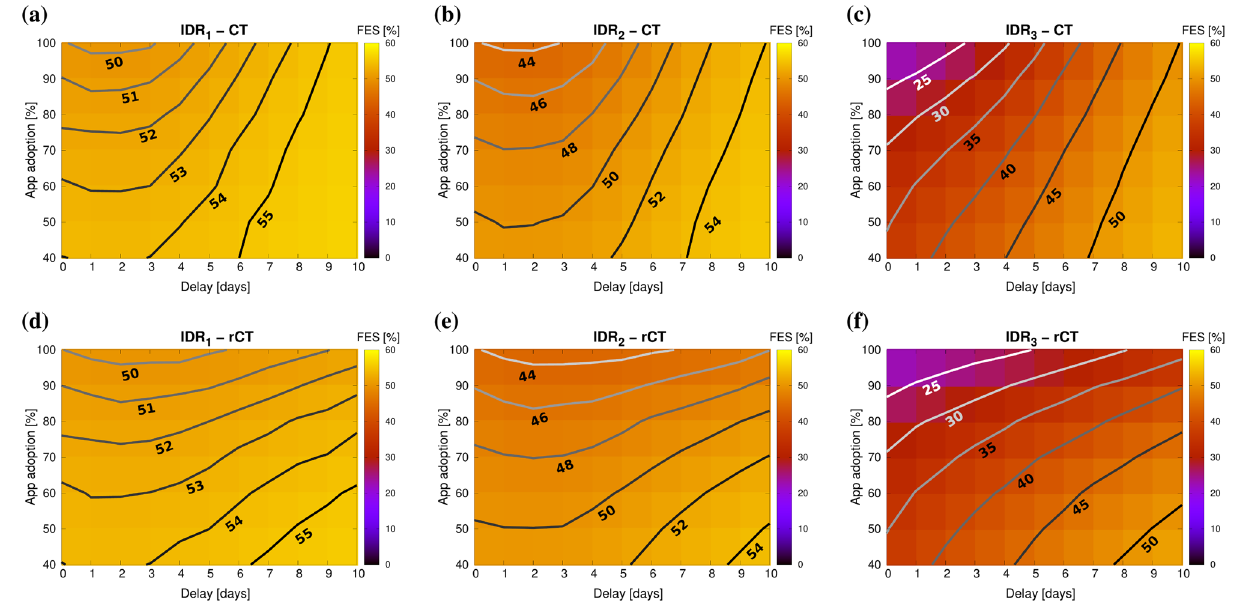
Figure 2. Final epidemic size shown as a heatmap, as a function of CT app adoption and delay (days from symptom onset to contact isolation). The performance of CT (above) and rCT (below) are compared for the three IDR scenarios detailed in Fig. 1. Contour lines for different FES values are shown. Greater delays, low app adoption, and low IDRs result in high FES values, which indicate low CT effectiveness.